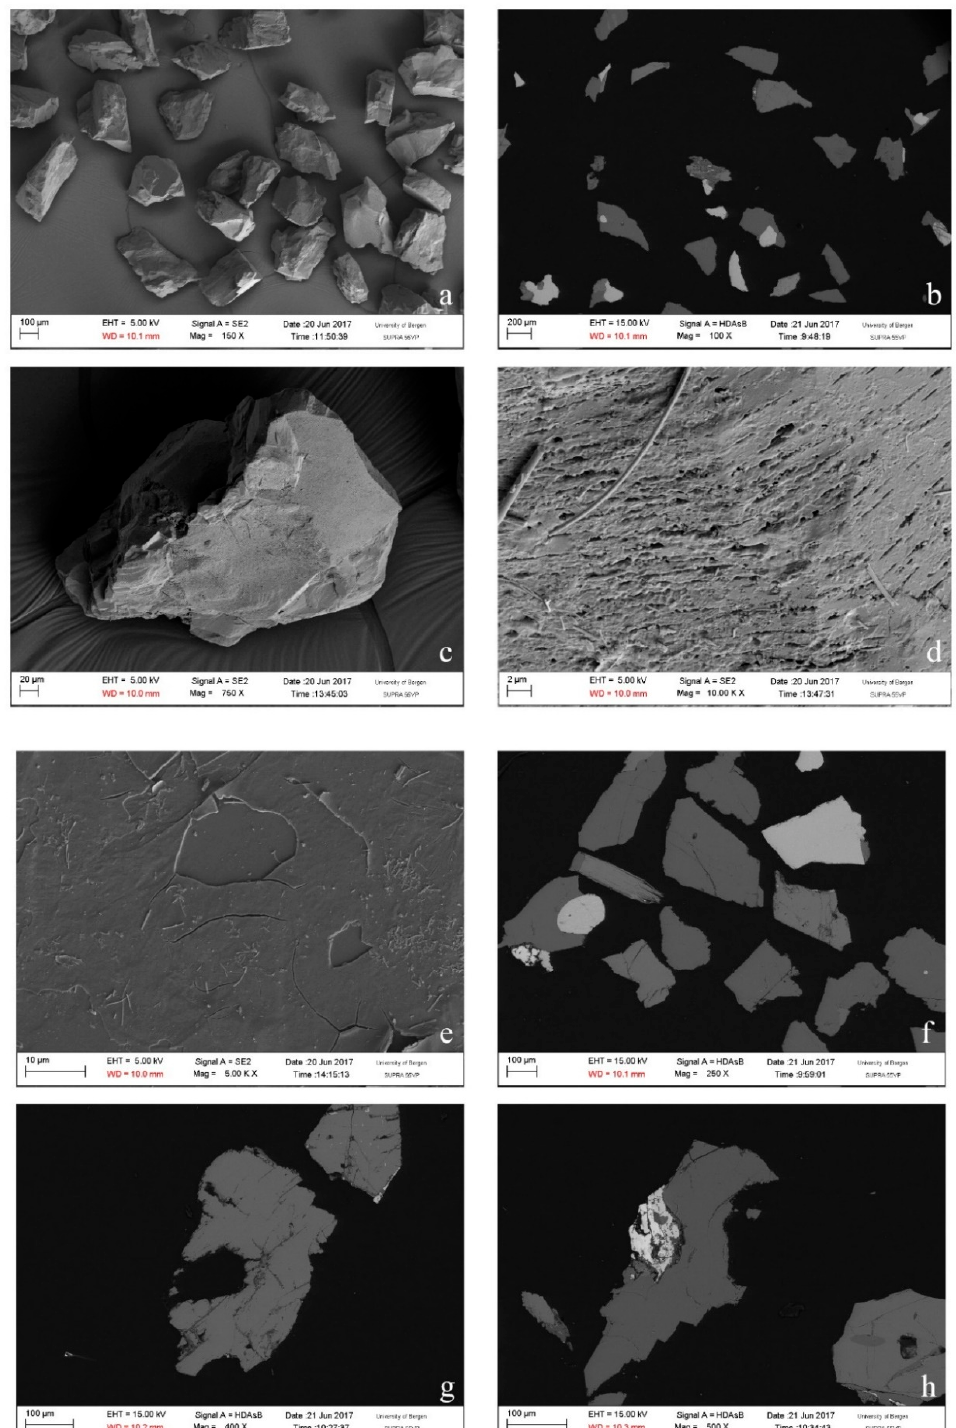
Figure 5. SEM micrographs of unreacted ( a , b ) and reacted ( c – h ) ilmenite norite grains. Both loose grains ( a , c – e ) and polished sections ( b , f – h ) are shown. In ( c , d ), note the etching along Fe-enriched exsolution lamellae in ilmenite. Image ( e ) shows effects of dissolution on a biotite surface, where leaching or precipitation resulted in the formation of a thin layer. The cross-sections ( f – h ) show some cavities resulting from the removal of mineral phases. The light phase in ( g ) shows minor surface roughening due to preferential dissolution.